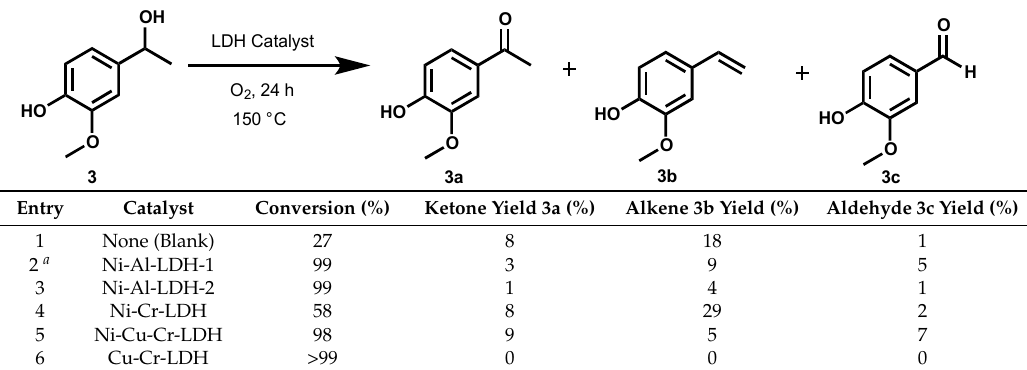
Table 6. Conversion of 3 over LDHs in phenyl ether with O 2 .